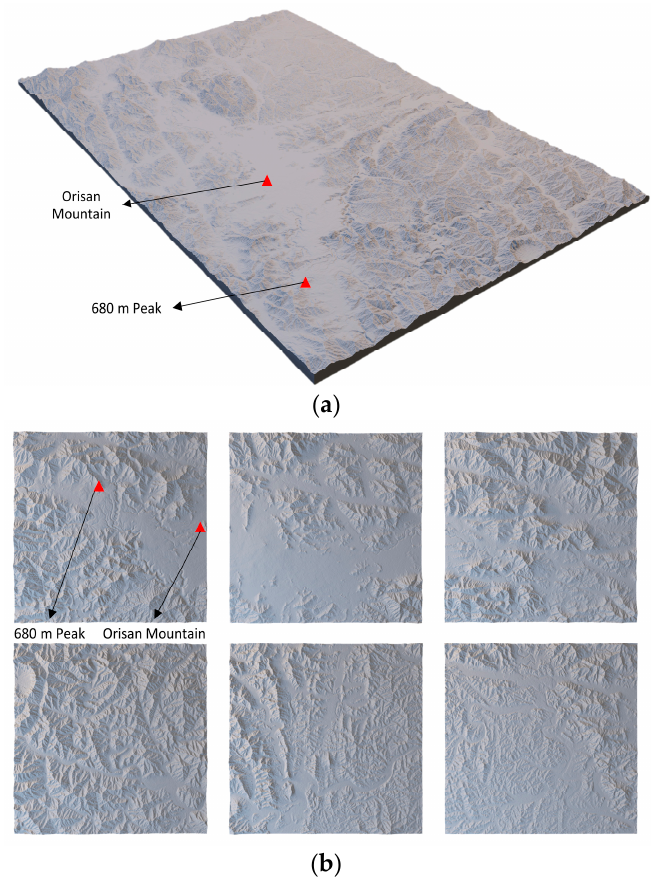
Figure 2. Digital view of ( a ) the 3D terrain surface from DEM SRTM; ( b ) final model divided into 6 parts to fit the printer’s build size.